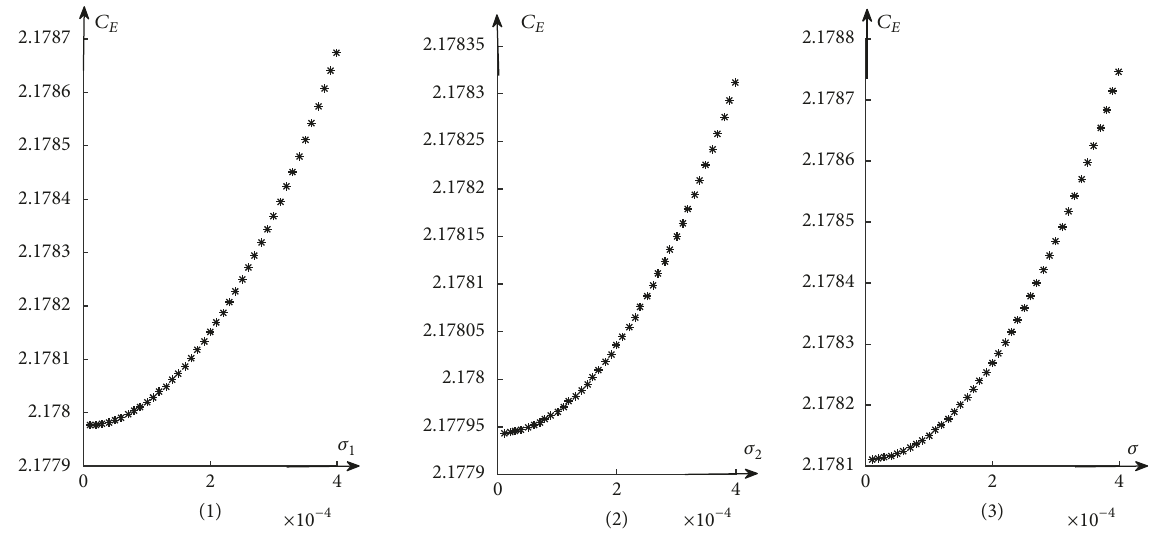
Figure 3: European call currency option price 𝐶 𝐸 versus parameters 𝜎 1 , 𝜎 2 , and 𝜎 , where (1) 𝐶 𝐸 versus 𝜎 1 ; (2) 𝐶 𝐸 versus 𝜎 2 ; (3) 𝐶 𝐸 versus 𝜎 .